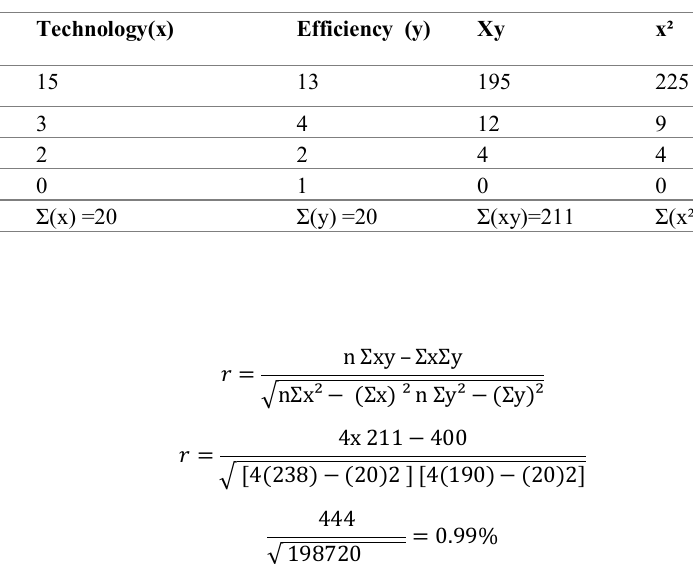
Table 4: Analysis of the relationship between technology and efficiency